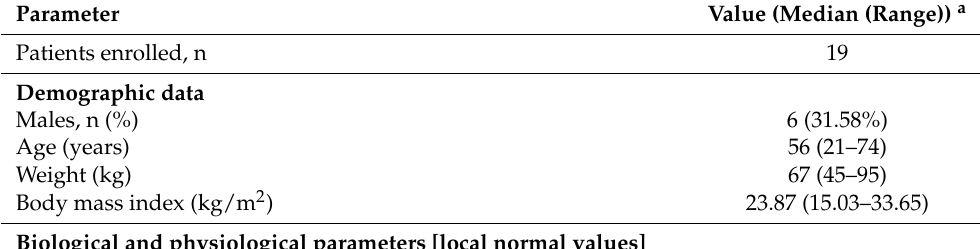
Table 1. Demographics and characteristics of